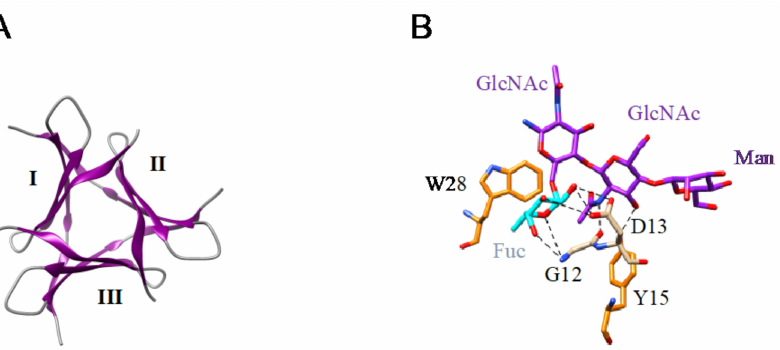
Figure 12. ( A ). Arrangement of the three antiparallel β -sheets (I, II, III) forming the PhosL ho- motrimer (PDB code 5XZK) to mimic a pseudo- β -trefoil structure. ( B ). Network of hydrogen bonds (black dashed lines) anchoring the fucose (Fuc, colored cyan) α 1,6-linked for the first GlcNAc from a fucosylated N -glycan to the CBS of PhosL (PDB code 6FX1). Aromatic residues Y89 and Y90 participating in stacking interactions with the pyranose rings of mannobiose are colored